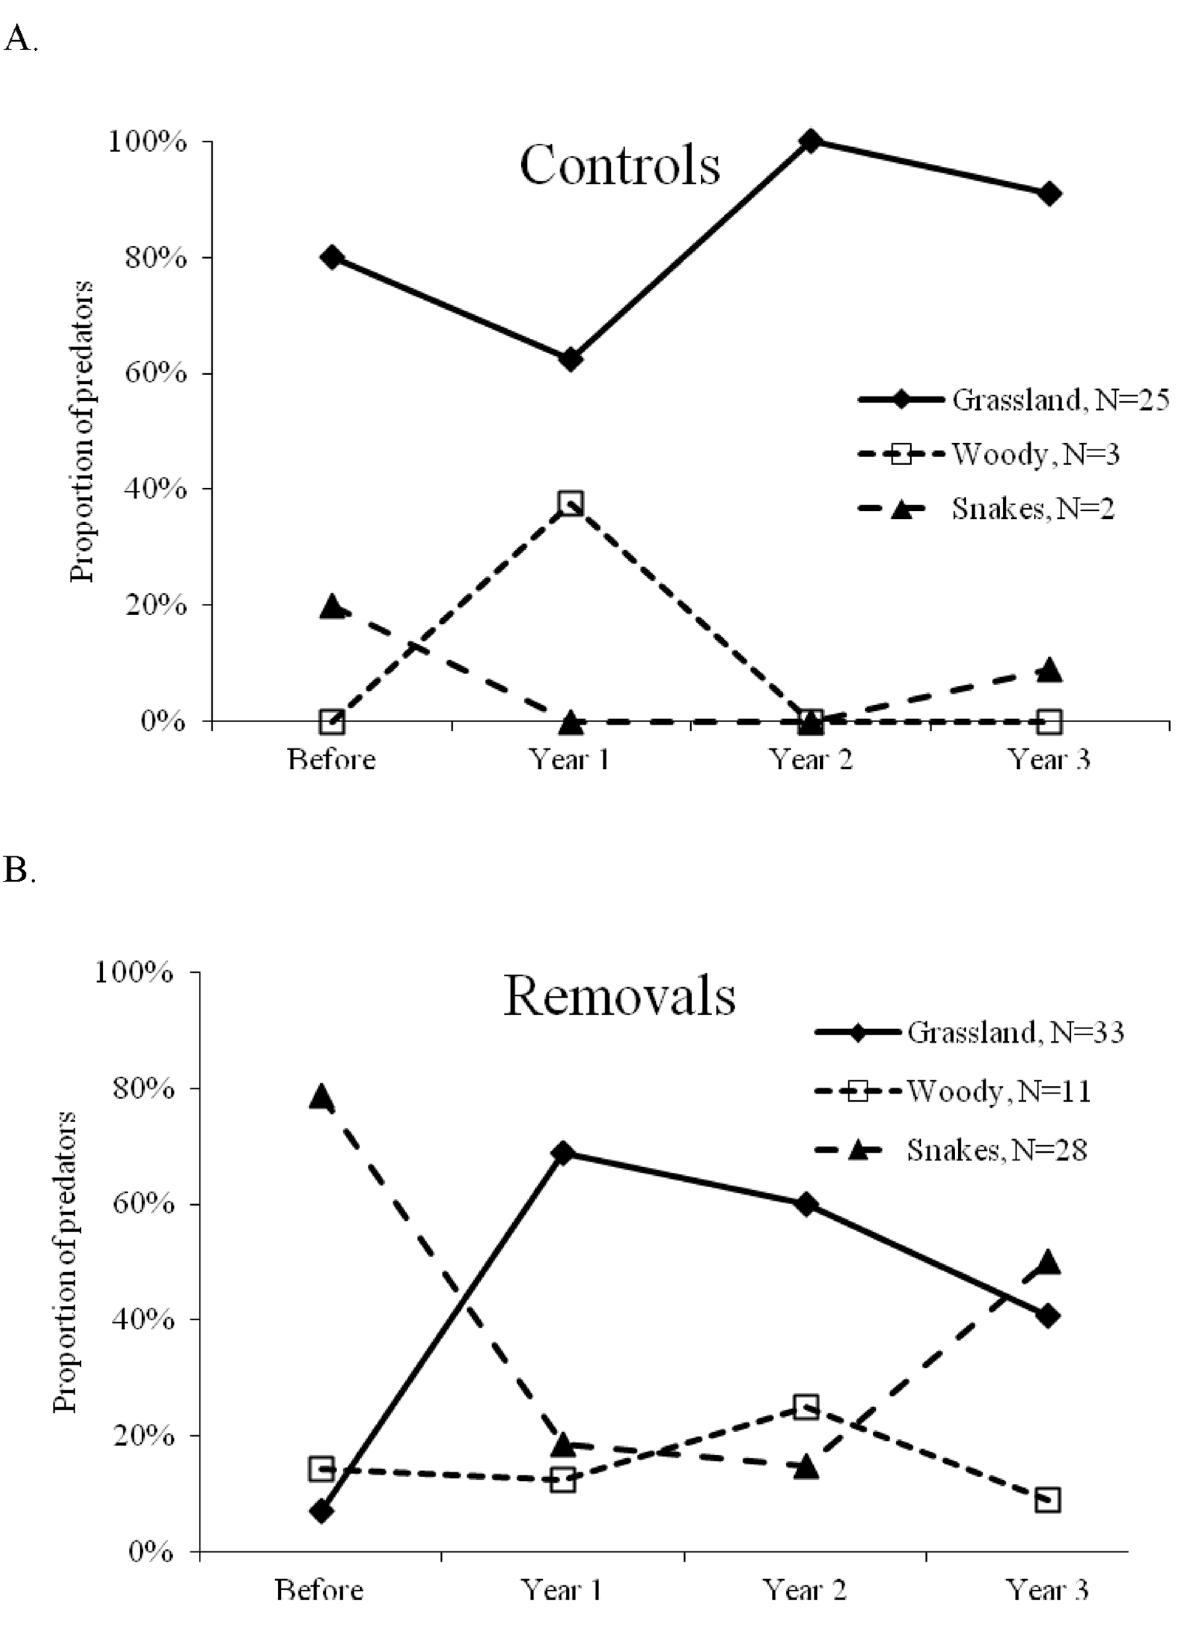
Figure 4. Nest depredation by predator group and year. Proportions for the (A) control and (B) tree row removal sites.